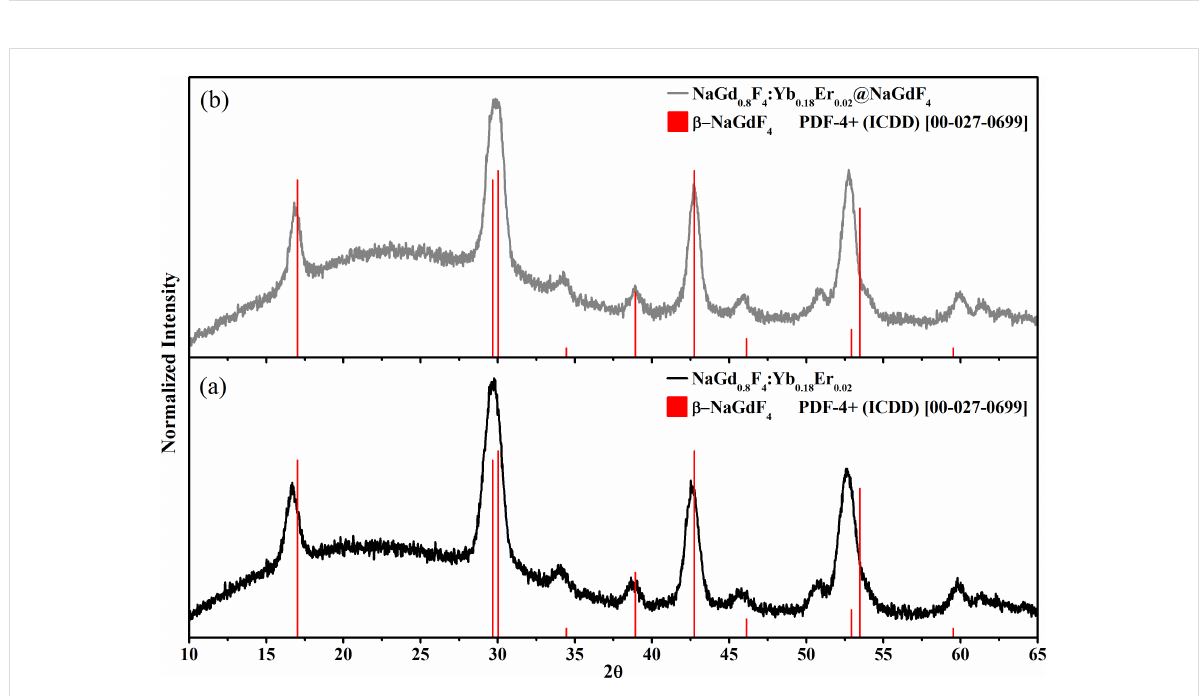
Figure 2: XRD pattern of NaGdF 4 :Yb,Er core only (a), and NaGdF 4 :Yb,Er@NaGdF 4 core–shell (b) nanoparticles.